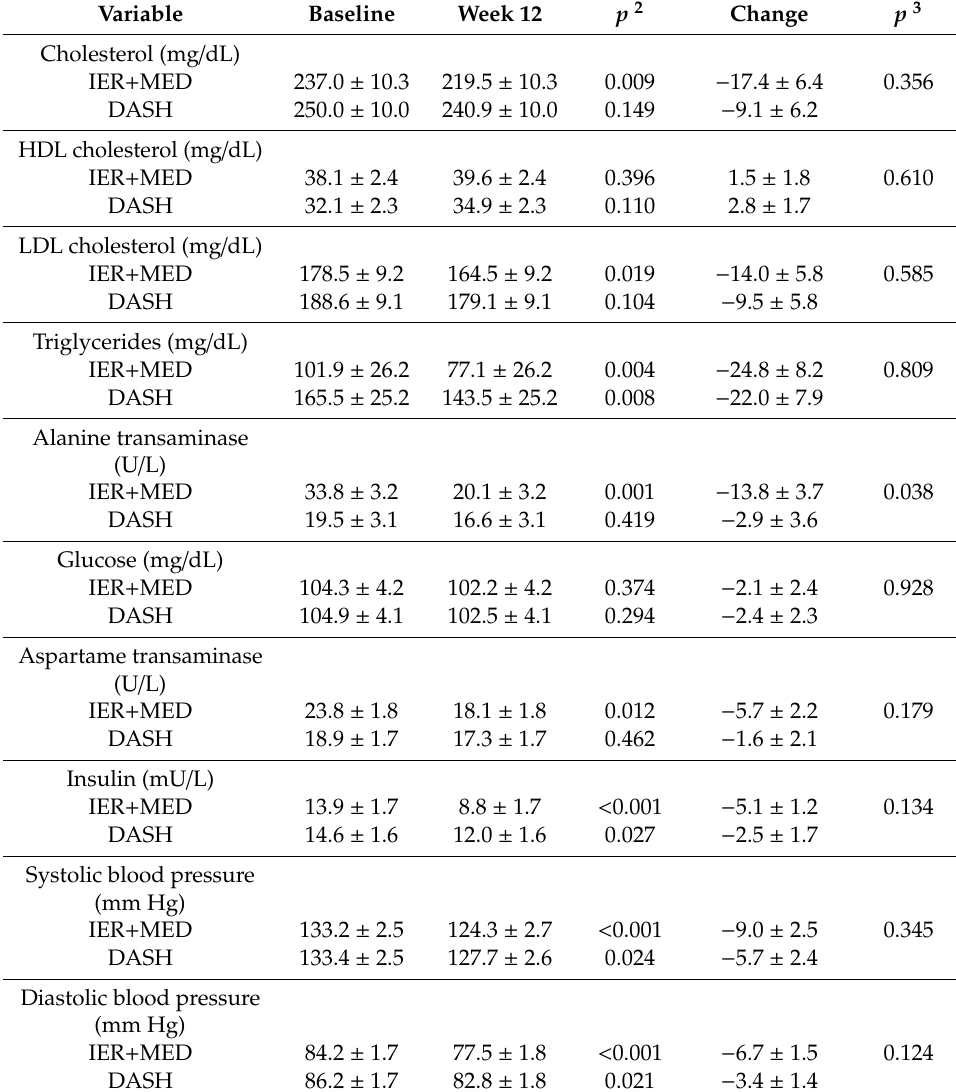
Table 4. Baseline, Week 12, and change in metabolic risk biomarkers within and between the IER + MED group ( n = 30) and the DASH group ( n = 30) 1